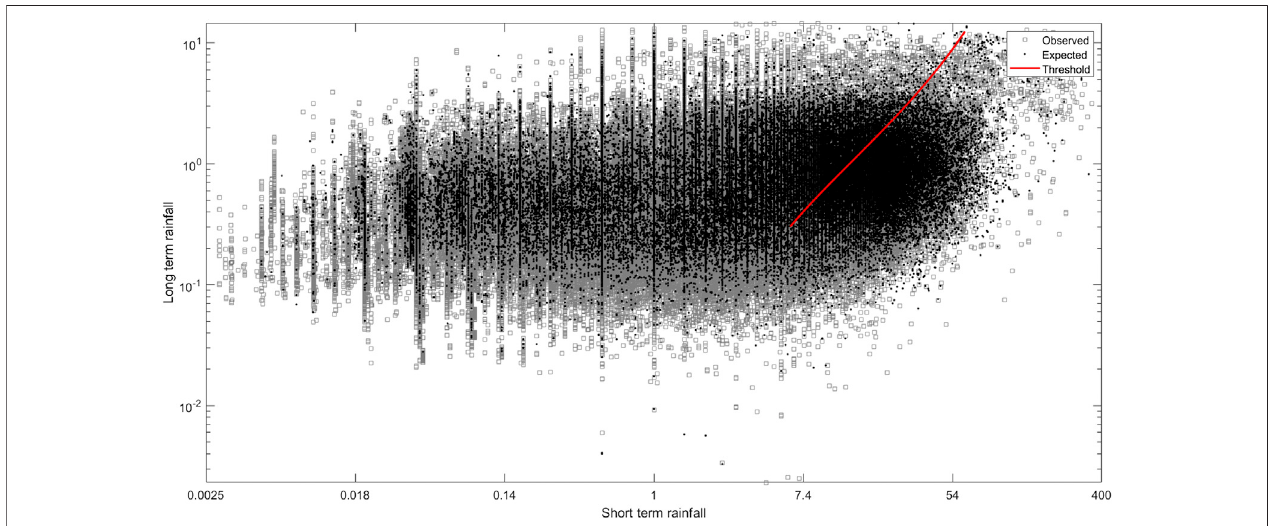
FIGURE 10 | Comparison of short- and long-term rainfall components for days with and without landslides. The red line represents the threshold calculated from Peruccacci et al. (2017).